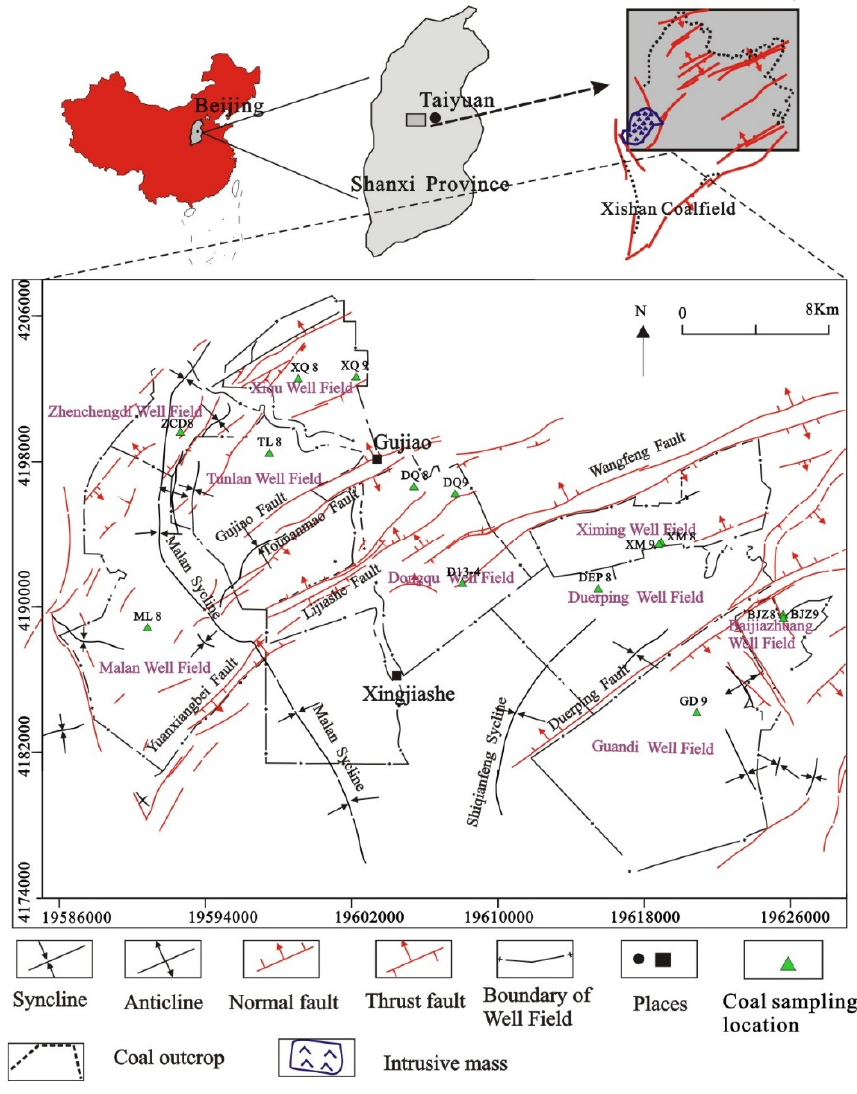
Figure 1. Structural outlines and distribution of sampling points in the study area.